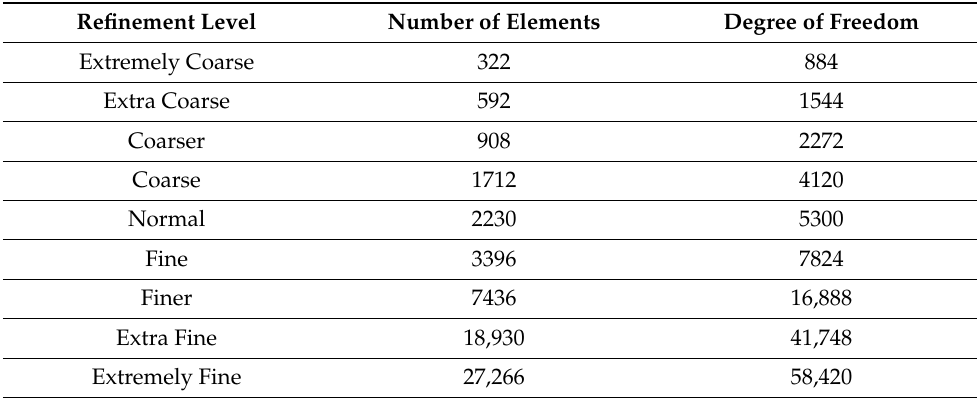
Table 3. Tabular data for DOFs at different refinement